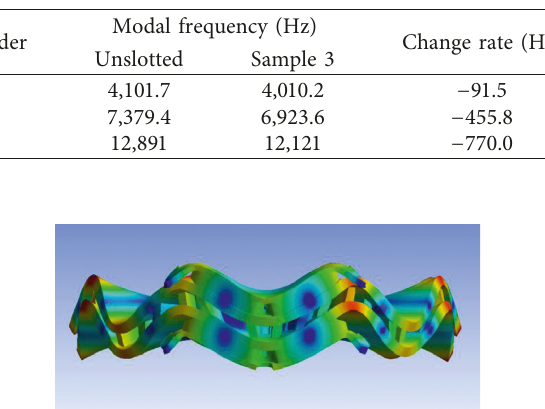
Table 9: Critical frequency change rate between unslotted back- plate and Sample 3.